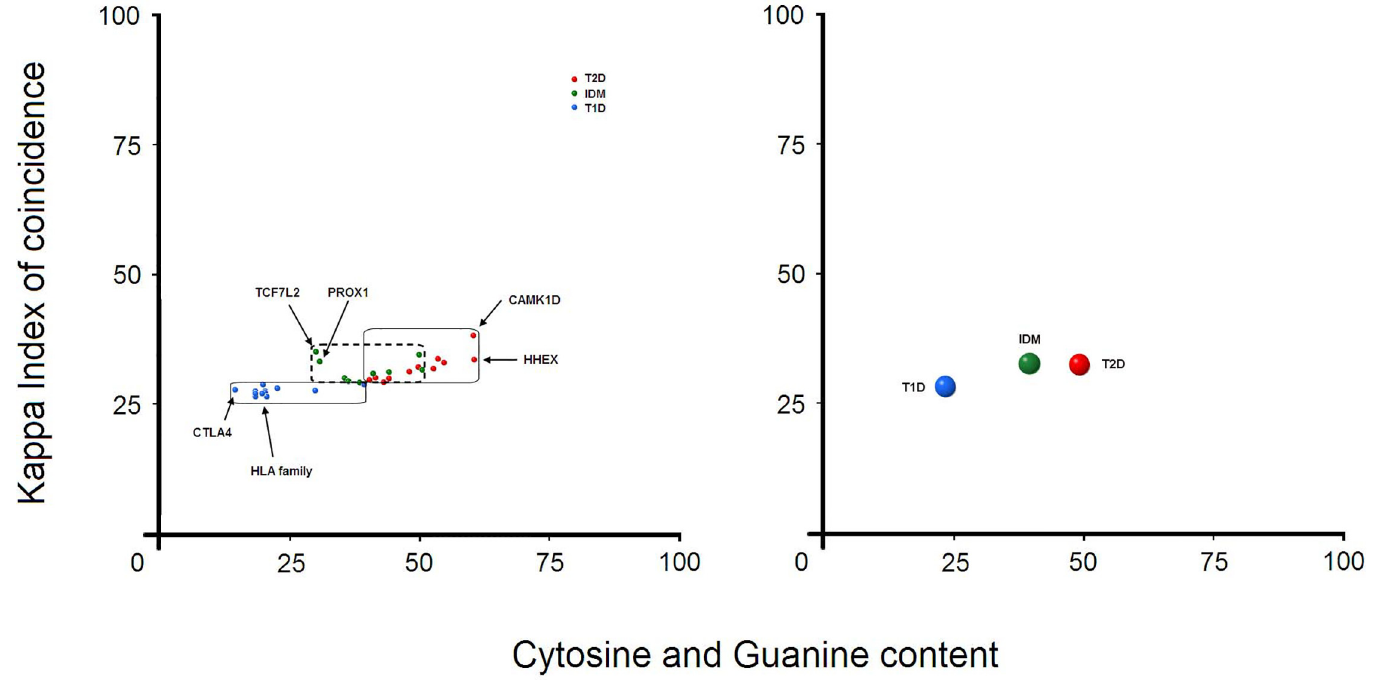
Fig 4. General distribution of the three phenotypes. (A) Complete separation of T1D and T2D after the inclusion of the intermediary phenotype and (B) the global distribution of the three